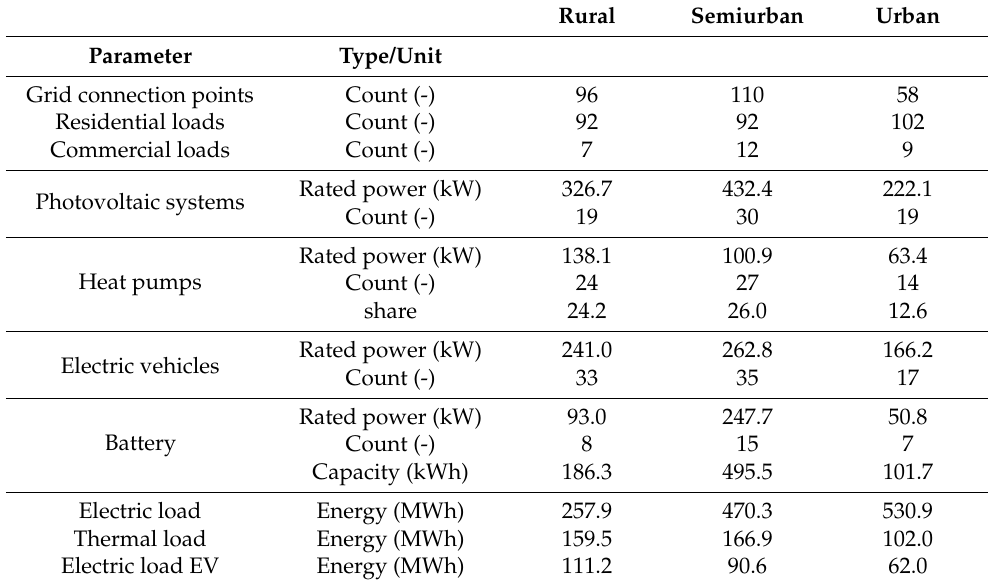
Table 1. Scenario assumptions for scenario year 2035, adapted from